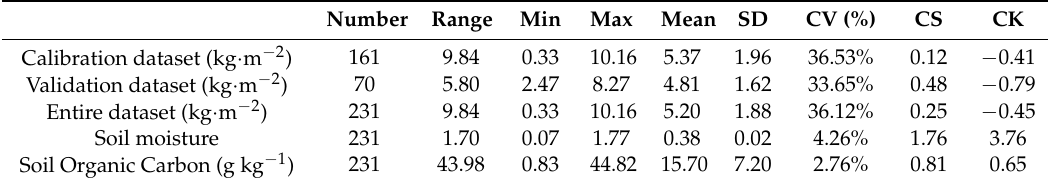
Table 1. Basic statistics of soil organic carbon density (SOCD), soil moisture and soil organic carbon in the entire, calibration, and validation datasets. Number Range Min Max Mean SD CV (%) CS